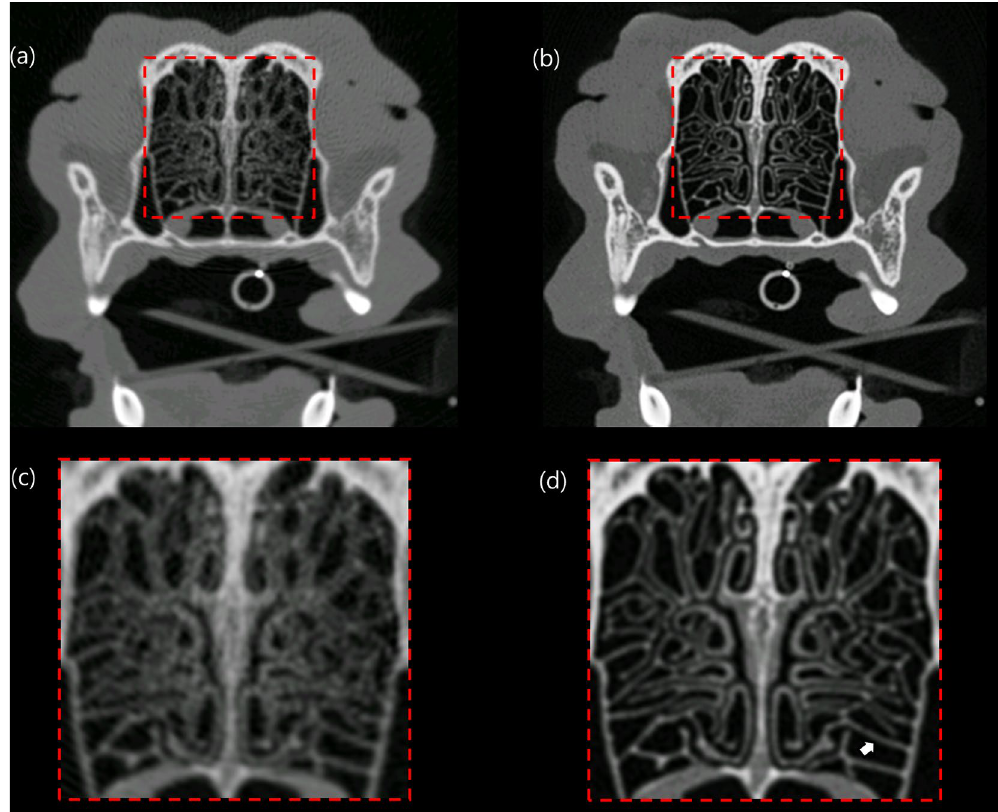
Figure 8. Axial images of the nasal turbinates scanned with the use of the ( a ) standard mode and ( b ) high- resolution (HR) mode of the PCD CT system. The average thickness of nasal turbinates (white arrow) is 0.5 mm. ( c , d ) The zoomed-in ROIs show better delineation of sub-millimeter nasal turbinates using ( c ) the HR modecompared with ( d ) the standard mode.